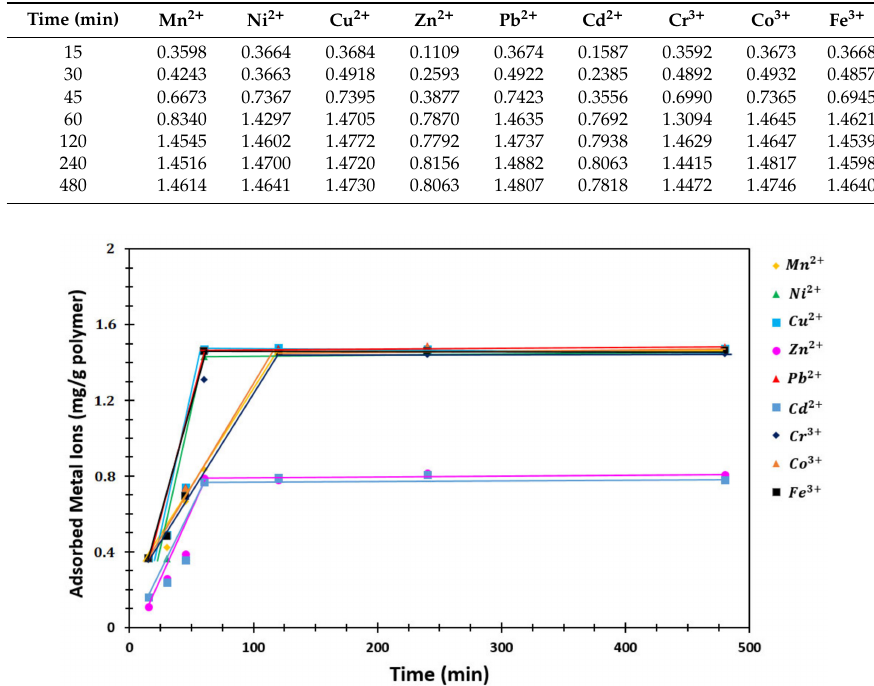
Table 2. The sorption rate values on the superabsorbent polymer (SAP) against di ff erent adsorption times of the metal ions (mg / g polymer).